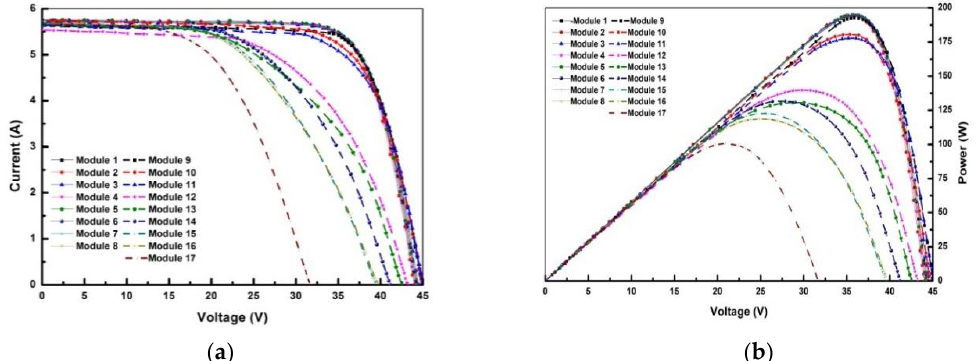
Figure 6. The current-voltage characteristics ( a ) and power-voltage characteristics ( b ) of 17 monocrystalline silicon solar modules dismounted from PID-affected module string 1. The larger negative potential did not induce more serious PID in proportion.